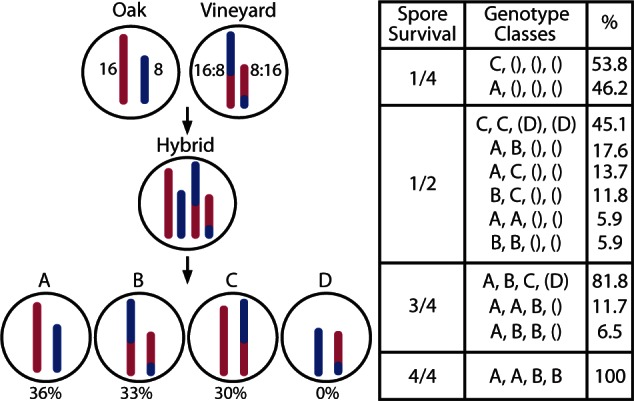
The Chr 8:16 translocation limits spore viability. The diagram to the left represents the Chr 8 and Chr 16 genotypes in the parent strains, the hybrid, and the four segregants (ignoring recombination for simplicity). The relative frequency of each genotype observed in 74–100 spores is listed below each genotype. The table to the right summarizes the observed tetrad-level genotypes classified by the number of viable spores (first column). () denotes dead spores that could not be genotyped and (D) denotes dead spores where genotype D is inferred. The last column (%) shows the percentage of each tetrad type per class.